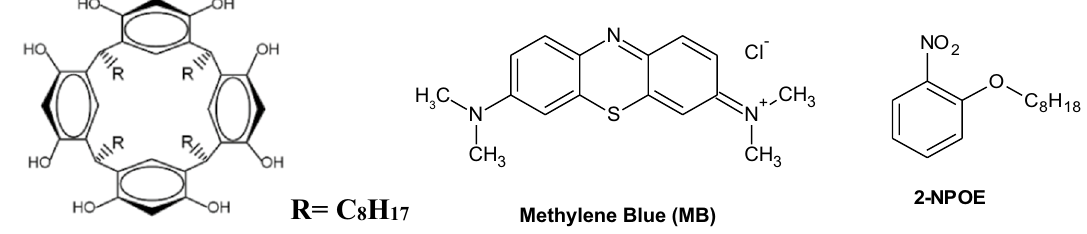
Fig. 1 Chemical structure of calix [4] resorcinarene (RC8), Methylene Blue (MB) and the plasticizer